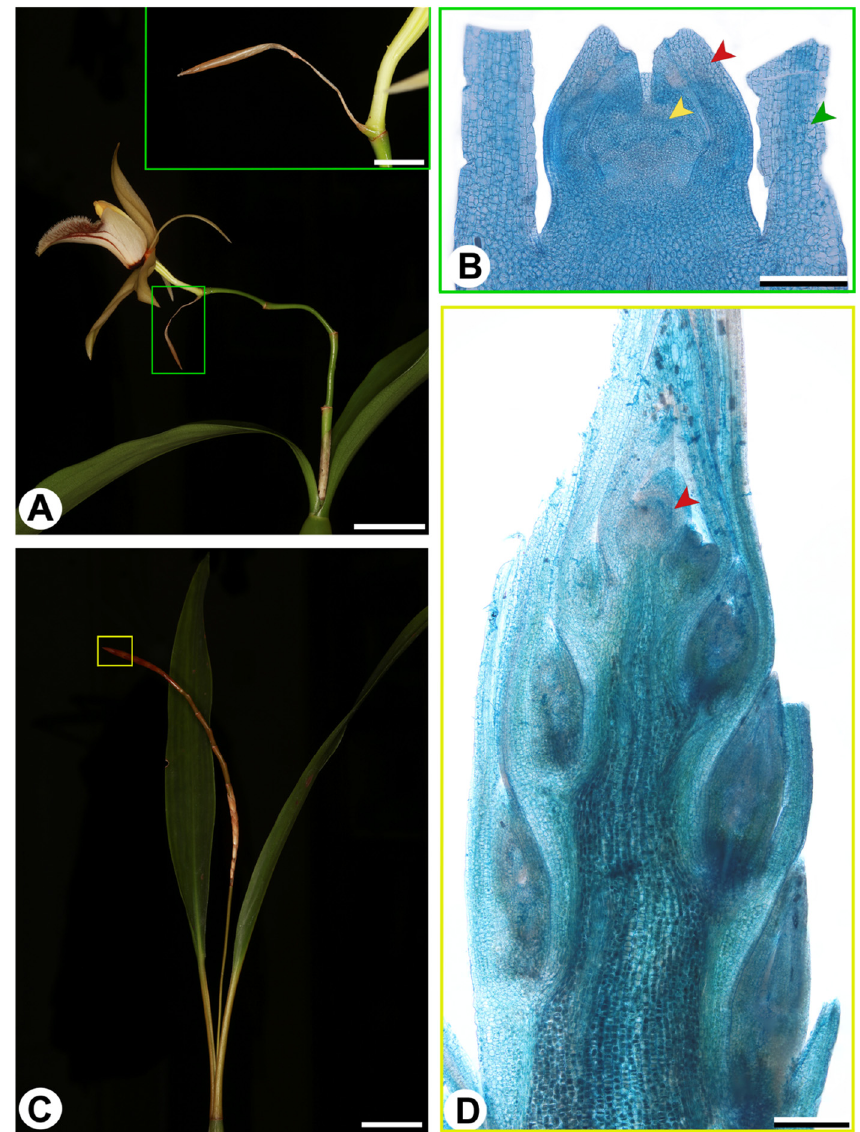
Figure 2. Inflorescences of C. ovalis and C. prolifera . ( A ) One-season inflorescence and flower of C. ovalis , green inset—last undeveloped bud with rudiment of apical flower; ( B ) rudimentary apical flower of C. ovalis , red arrow—rudiments of sepals, yellow arrow—rudiment of gynostemium, green arrow—bract; ( C ) inflorescence of C. prolifera with two intercalary clusters; ( D ) structure of the apical floral zone of C. prolifera with flower primordia in the axils of bracts; red arrow, apical meristem. Scale bars: ( A ) = 2 cm (green inset = 0.5 cm); ( C ) = 1.5 cm; ( B , D ) = 0.6 mm.